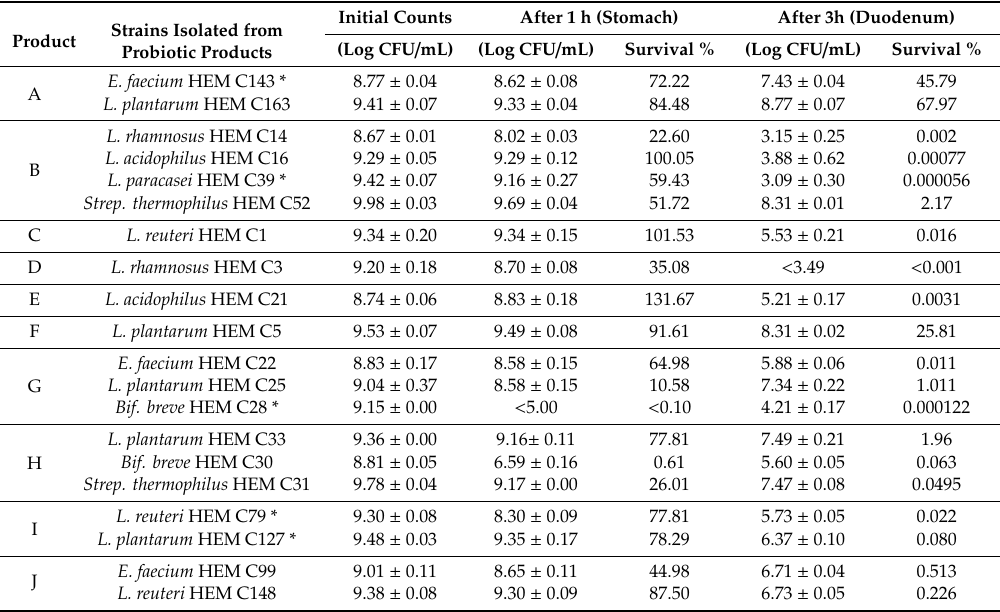
Table 4. Survival of di ff erent microorganisms isolated from commercially available probiotic products in simulated stomach-duodenum passage test. For strain numbers refer to Table